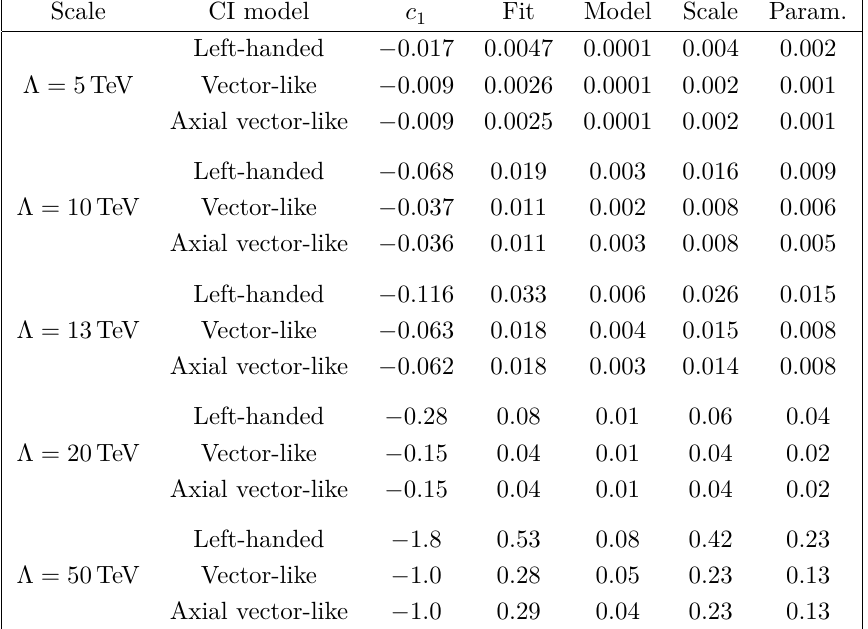
Table 7 . The values and uncertainties of the fitted Wilson coefficients c fit uncertainties are obtained by using the Hessian method.